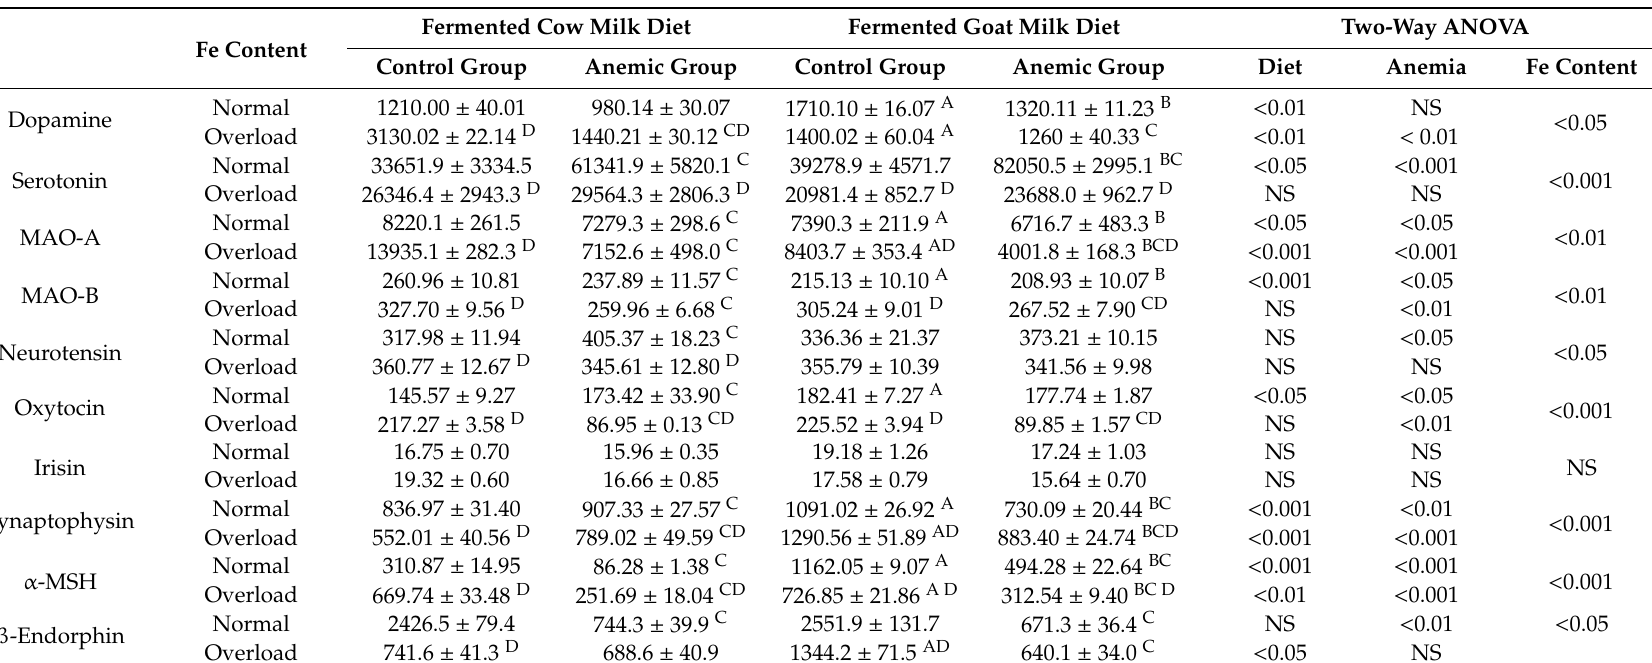
Table 4. Brain molecular function parameters in brain homogenate (pg mL − 1 ) from control and anemic rats fed for 30 days with fermented cow or goat milk-based diets with normal Fe content or Fe overload ( n = 10 animals per